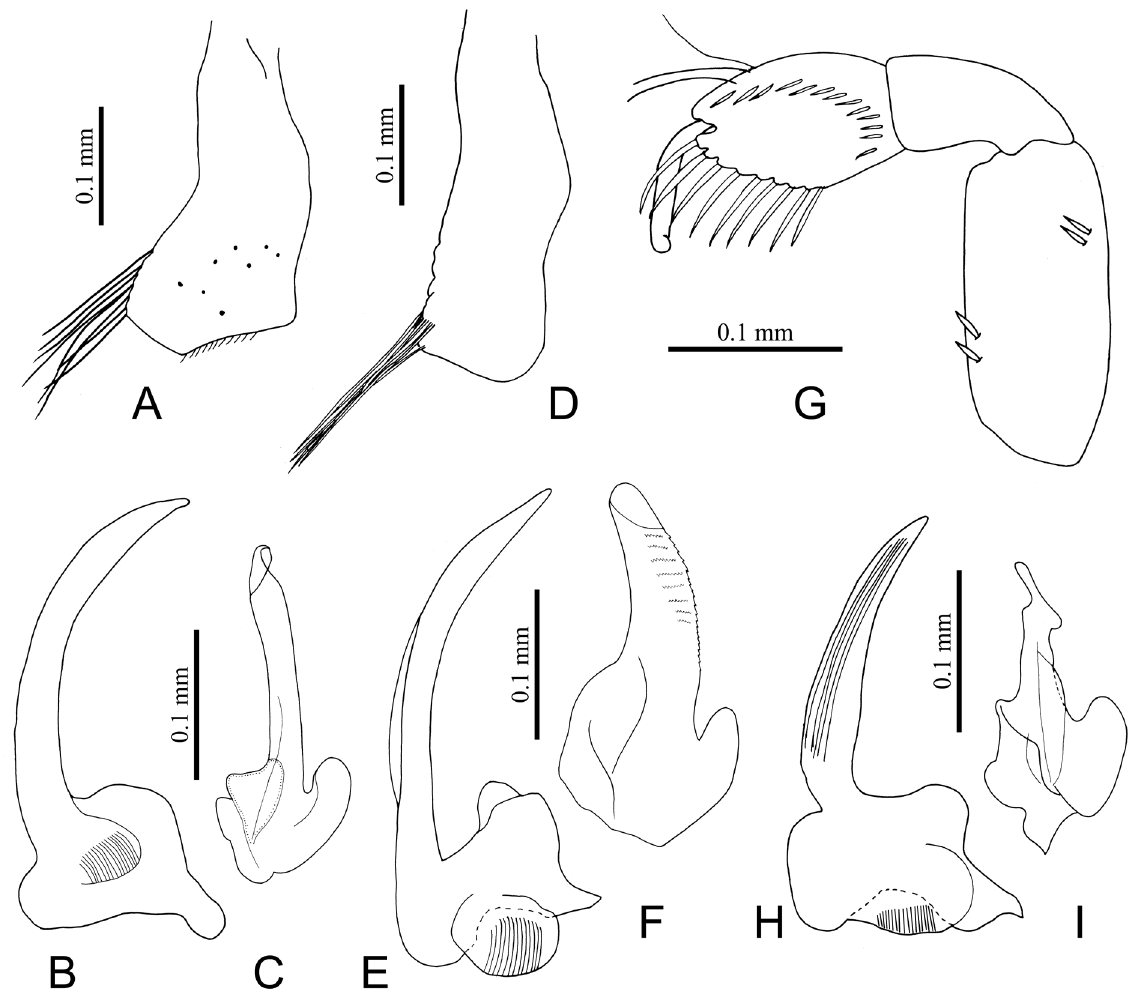
Fig. 3. Morphological features of species of Micronecta Kirkaldy, 1897, ♂♂. A–C . M . decorata Lundblad, 1933 (ZVNU). D–F . M. desertana Distant, 1920 (ZVNU). G–I . M. johorensis Fernando, 1964 (ZVNU). A, D = free lobe; B, E, H = right paramere; C, F, I = left paramere; G = fore